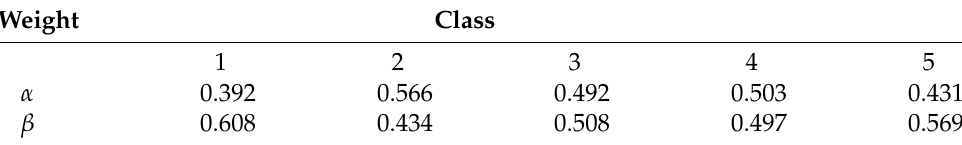
Table 2. Weight distribution in the fusion of the weighted